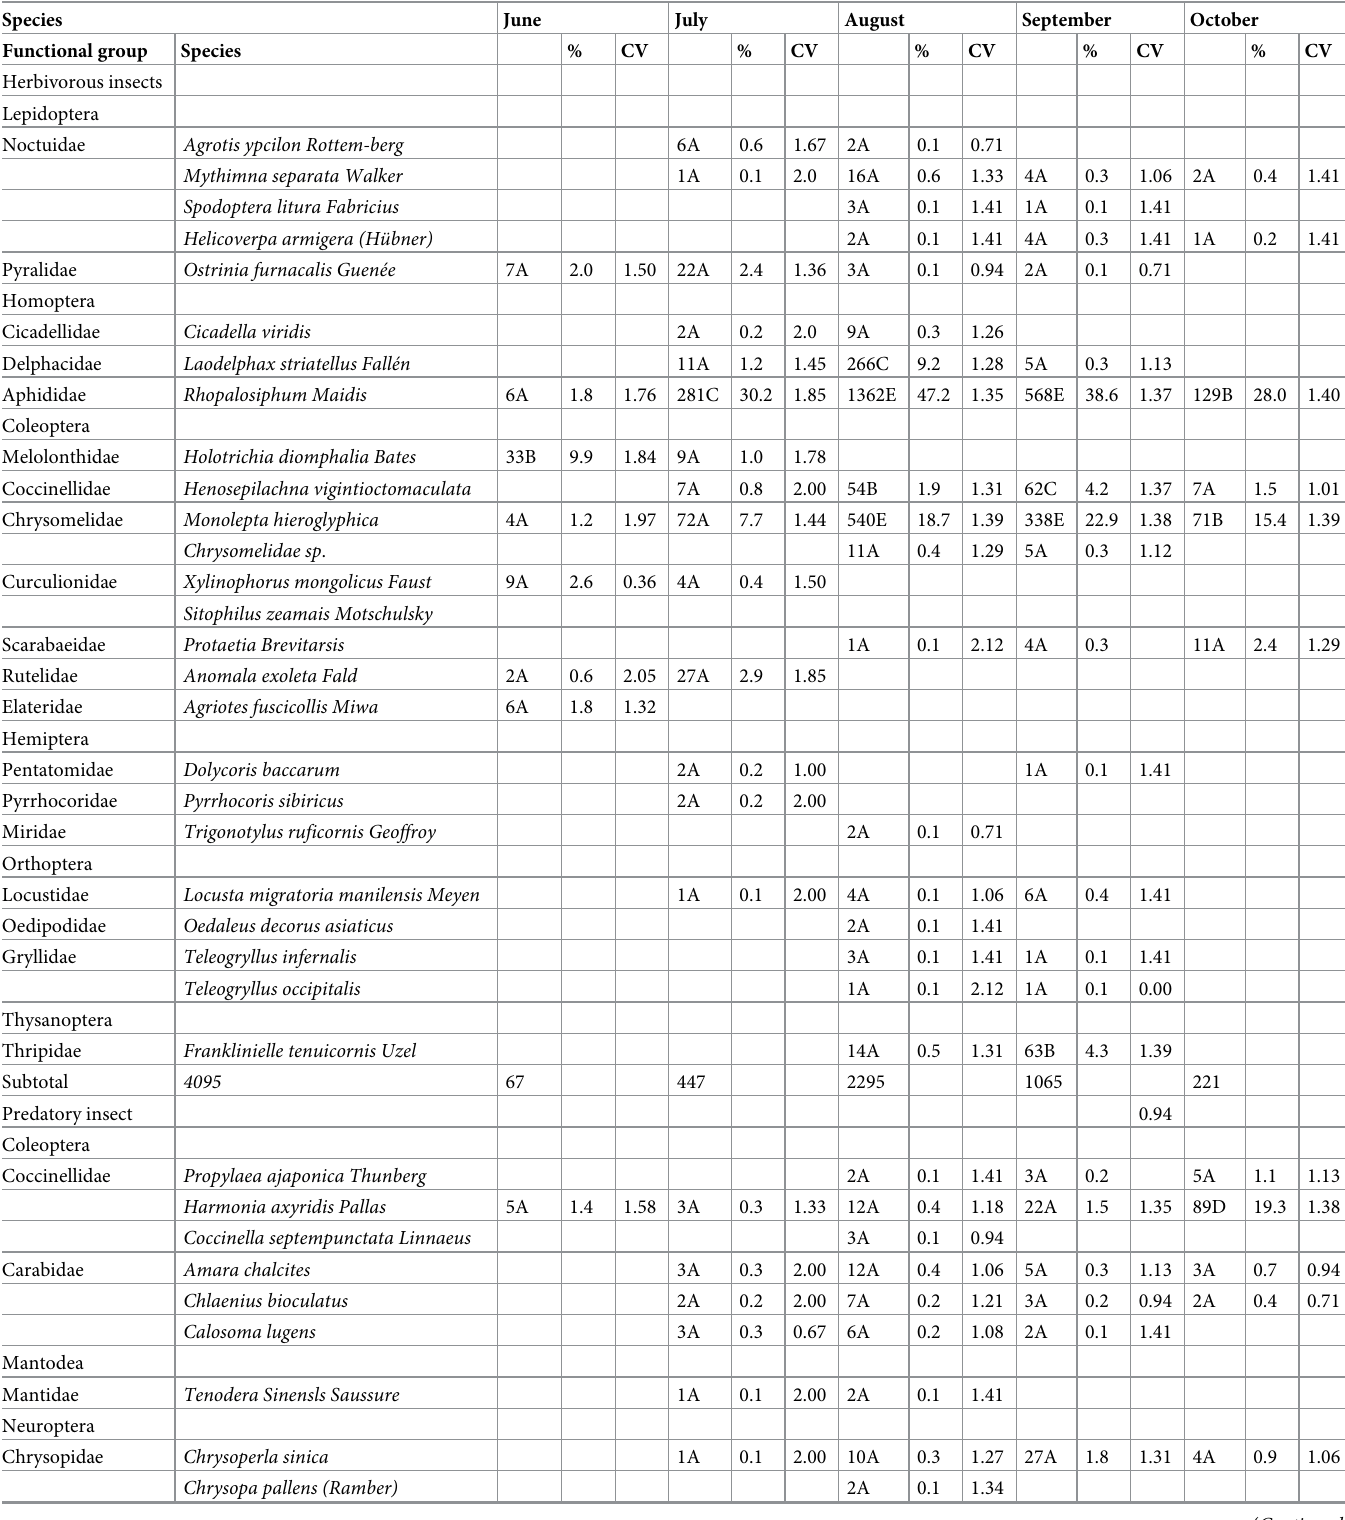
Table 1. Composition of insect community structure in corn farmland.